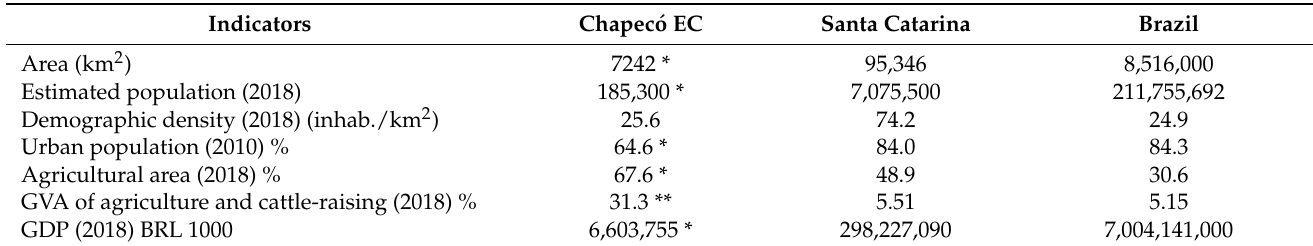
Table 1. Socioeconomic indicators.